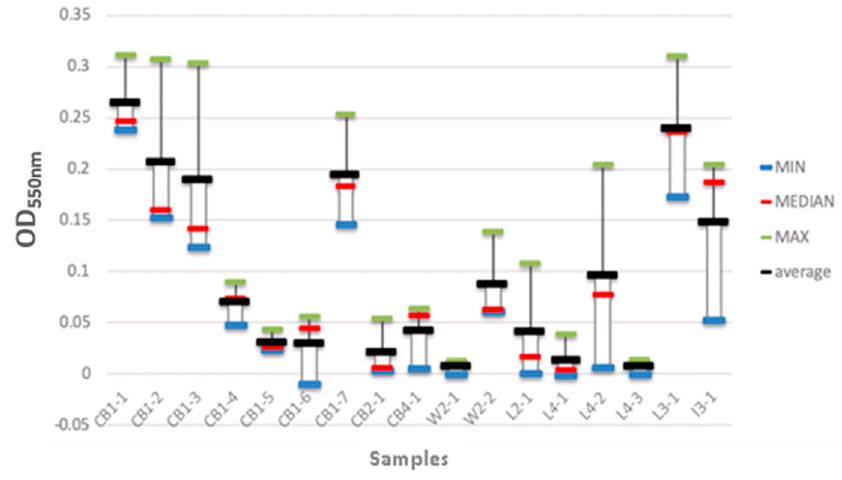
Figure 7. Biofilm biomass of the isolated bacterial strains. CB1-1 to CB1-7 represent the bacterial strains that were isolated from the wooden cutting board after the first week of incubation. CB2-1 represents the strains that were isolated from the cutting board after the second week of incubation. CB4-1 represents the strains that were isolated from the cutting board after the fourth week of incubation. W2-1 and W2-2 represent the strains that were isolated from the wet market meat samples after the first and second week of incubation, respectively. L2-1 and L3-1 represent the bacterial strains that were isolated from the local meat after the second and third week of incubation, respectively. L4-1 to L4-3 represent the bacterial strains that were isolated from local meat after the fourth week of incubation. I3-1 represents the bacterial strains that were isolated from imported meat after the third week of